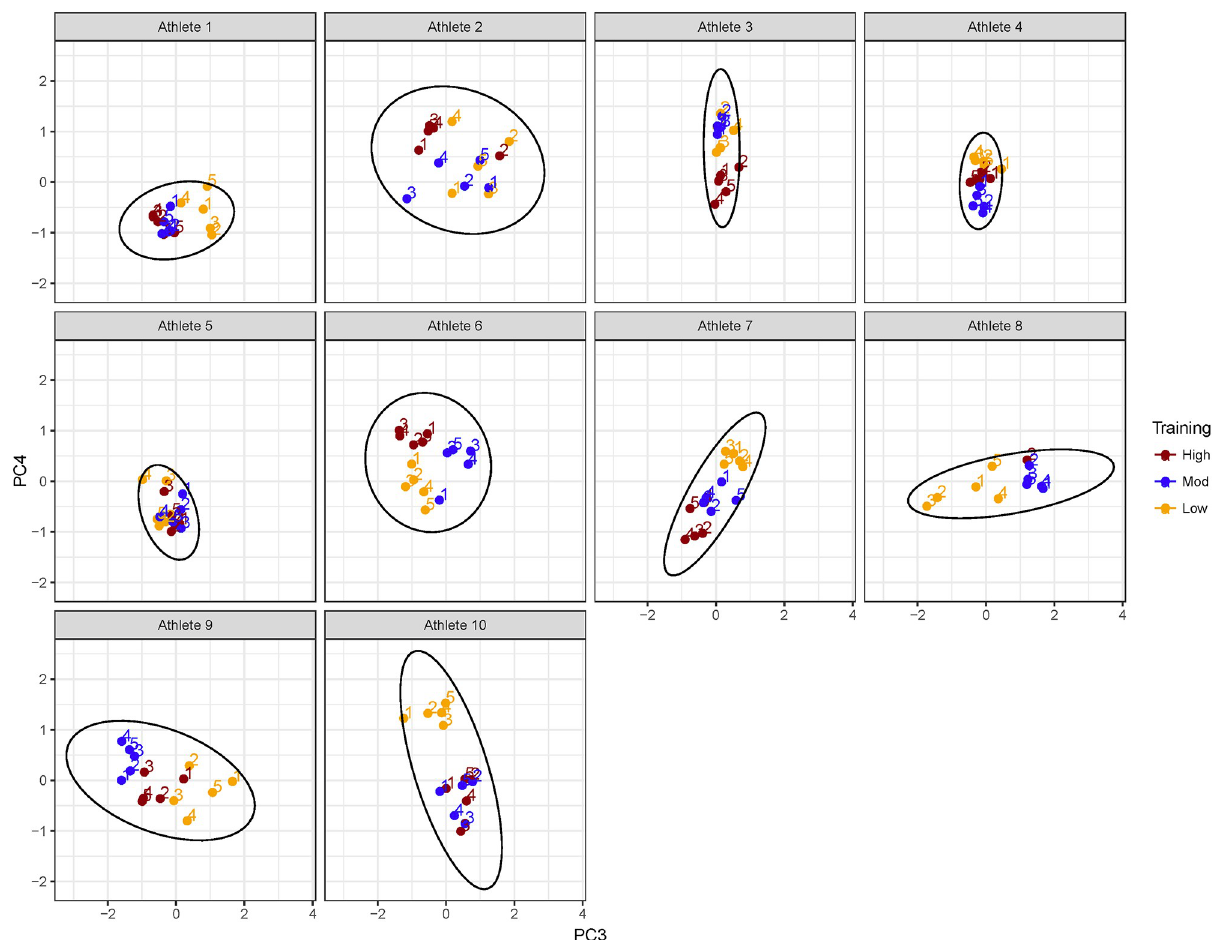
Fig 3. CMJ rel PeakF results plotted against PC3 and PC4, illustrating the grouping of individual athlete results showing greater clarity in groupings by training workload for each athlete.